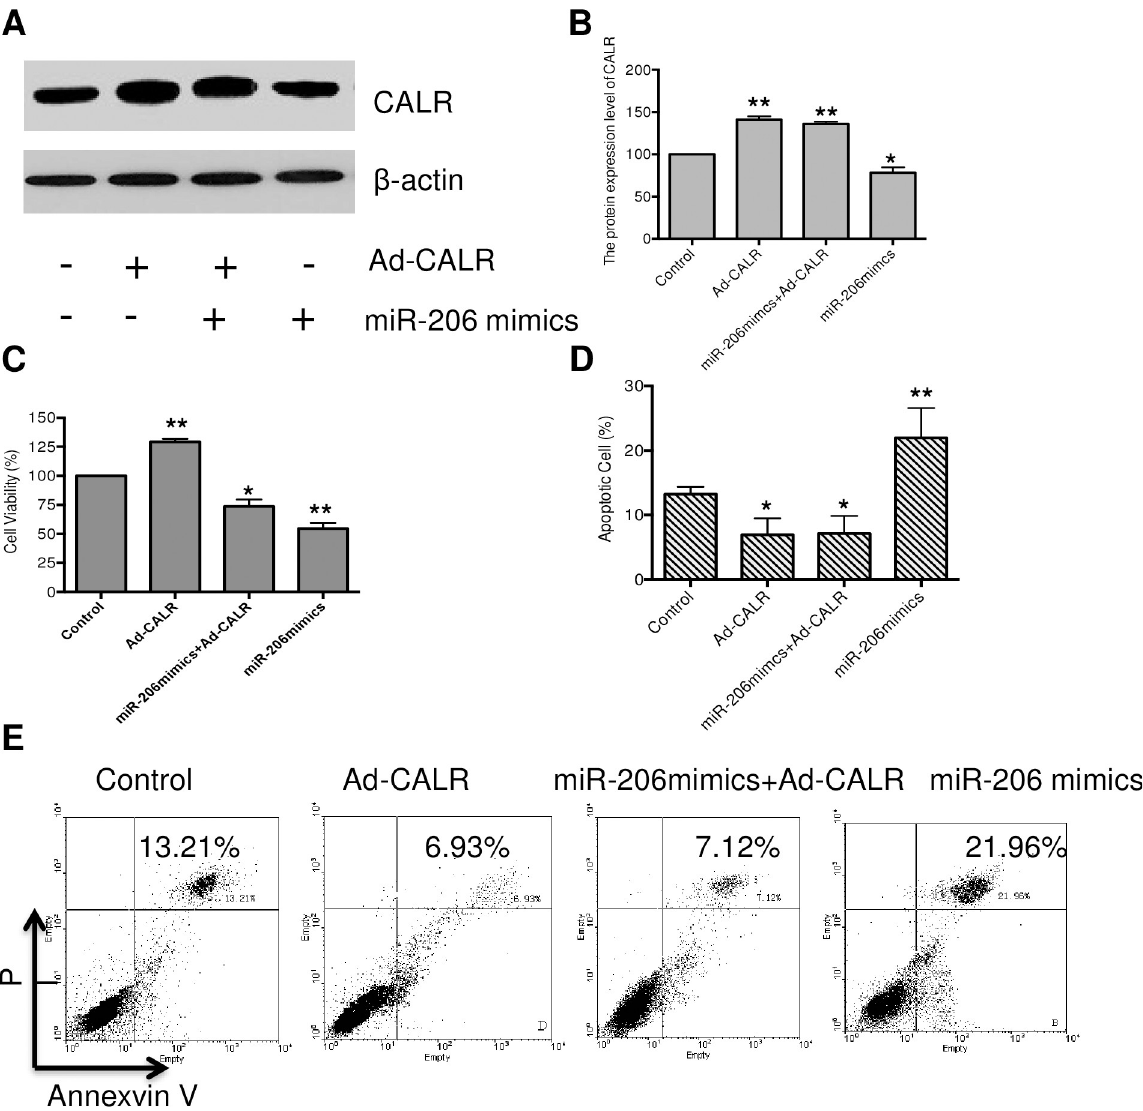
Fig 2. Overexpression of CALR attenuate the cytotoxic effect of miR-206 on growth of breast cancer stem cells. Human breast cancer stem cells were treated by miR-206 and/or Ad-CALR for 48 h, then the cells were harvested and analyzed. (A&B) CALR protein expression were determined by immunoblot analysis; (C) Human breast cancer stem cells were transfected with miR-206 and/or Ad-CALR for 72 h, the cell growth was determined by MTT assay; (D&E) Effect of CALR overexpression attenuate the apoptosis effect of miR-206 in breast cancer stem cells. Human breast cancer stem cells were treated by miR-206 and/or Ad-CALR for 48 h, the early and late apoptotic cells were measured by PI-Annexin V, � P < 0.05, �� P < 0.01 vs. control